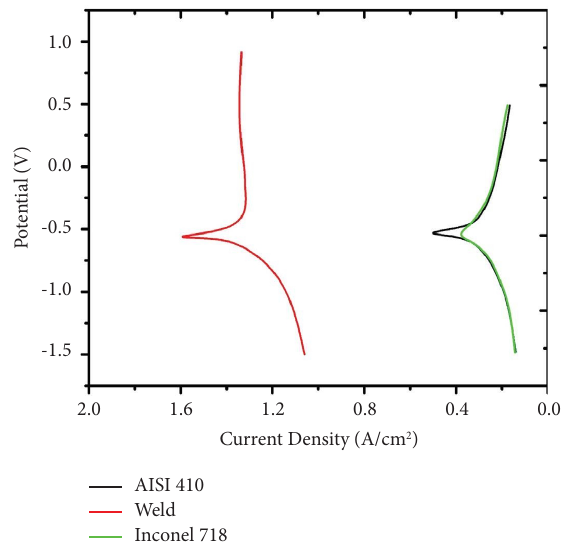
Figure 14: Polarization curves for base metal and weld